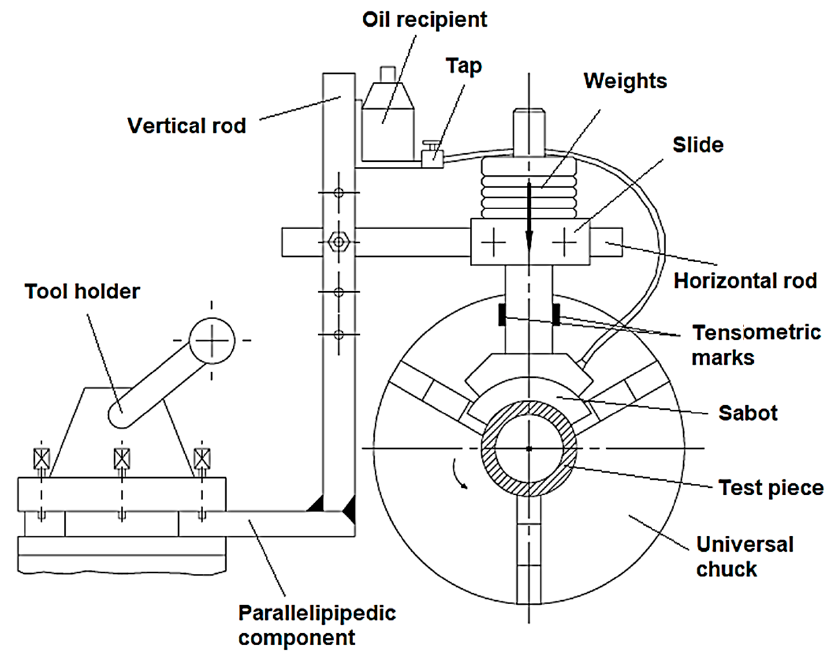
Figure 2. Equipment for testing the wear behavior of surfaces obtained by distinct processing meth-